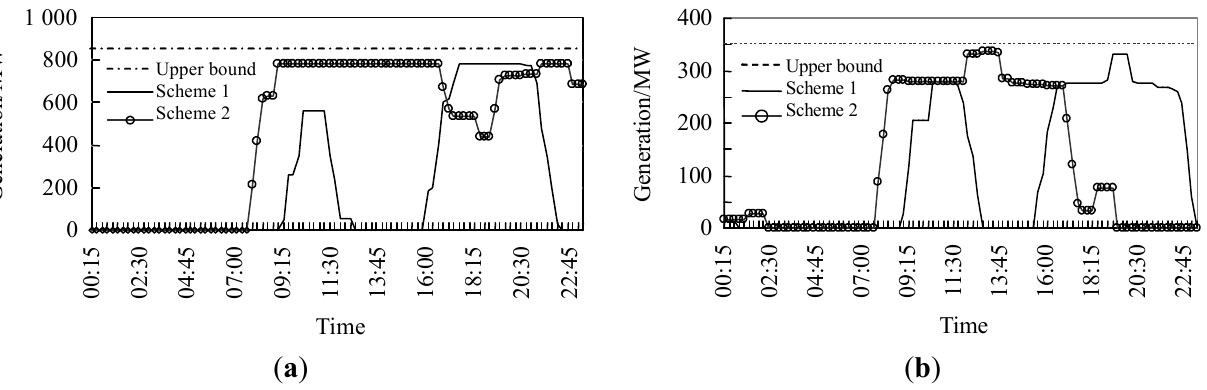
Figure 7. Load balance profiles in Scheme 2: ( a ) SHPG; and ( b ) ZJPG.